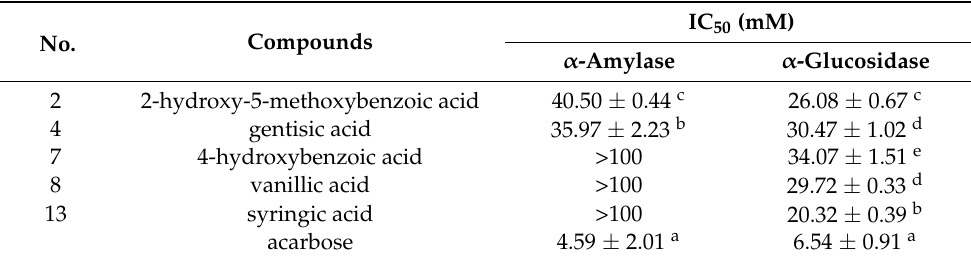
Table 1. The half maximal inhibitory concentration (IC 50 ) of benzoic acid derivatives against α - amylase and α -glucosidase. Values (mean ± SD) with different letters within each column have a significant difference at p <